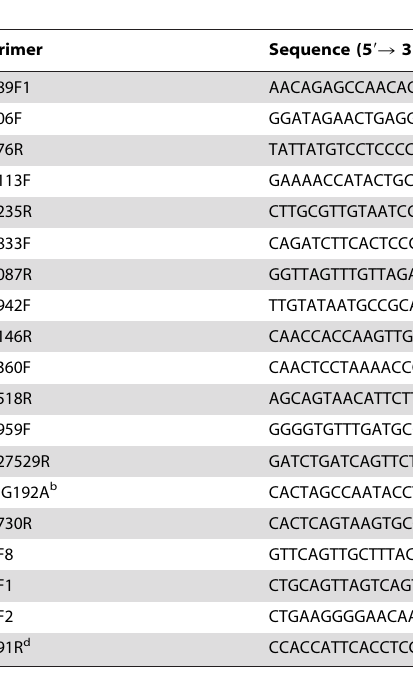
Table 4. Primers used to amplify the MgPa operon and MgPar